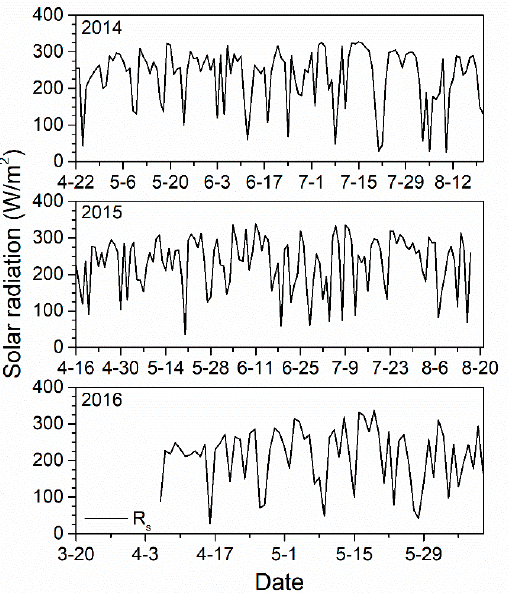
Figure 1. Seasonal variations of the daily average solar radiation (R s ) in 2014–2016. Note: The data of solar radiation in 2017 was missed because of equipment failure.